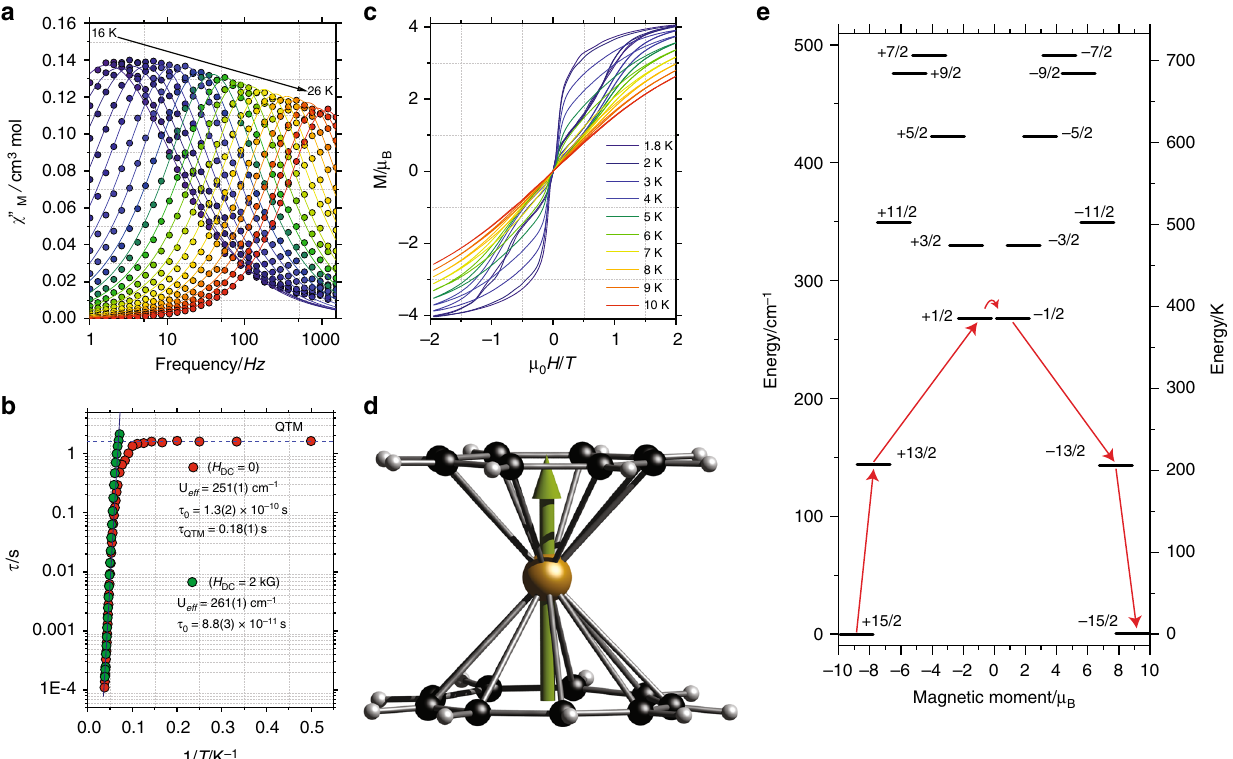
Fig. 7 Magnetic properties of 3d . a Experimental out-of-phase magnetic susceptibility ( χ M ” ( ν )) for 3d in the temperature range of 16 to 26 K ( fi lled circles). Solid lines are the fi ttings to a generalized Debye model. b Arrhenius analysis of the relaxation times ( τ ) for 3d with H DC = 0 (red) and with H DC = 2 kG (green). The black line corresponds to the thermally active regime, whilst the blue dashed line represents the QTM regime. c Hysteresis measurements for 3d between ±2 T and from 1.8 K to 10 K employing a fi eld sweep rate of 700 G/s; d optimized structure of 3d and direction of the principal magnetic anisotropy axis obtained from CASSCF calculations (green arrow). e ab initio calculated electronic states of the J = 15/2 manifold of the 4 I term of 3d and the most probable relaxation pathway for the magnetization represented by the red arrows, involving spin phonon excitation to the fi rst and second doublets. The thick black lines represent the Kramers doublet states as function of their magnetic